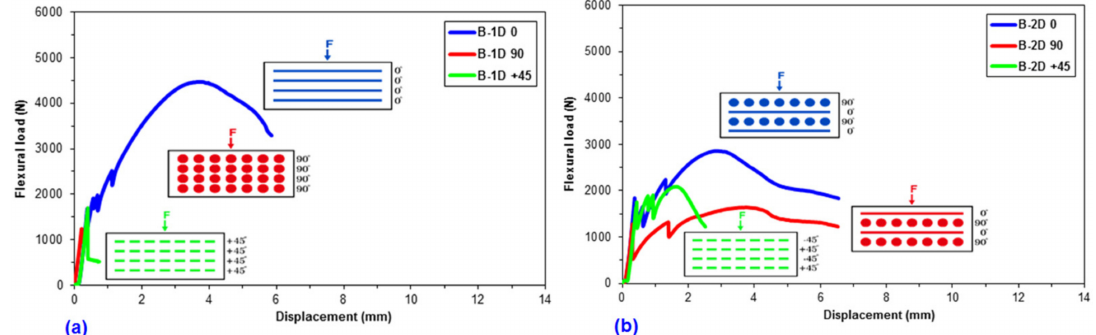
Figure 8. General characterization of the off-axis flexural load-displacement graph of the multiaxis 3D basalt TOWs concretes. ( a ) B-1D concrete composite and ( b ) B-2D concrete composite.